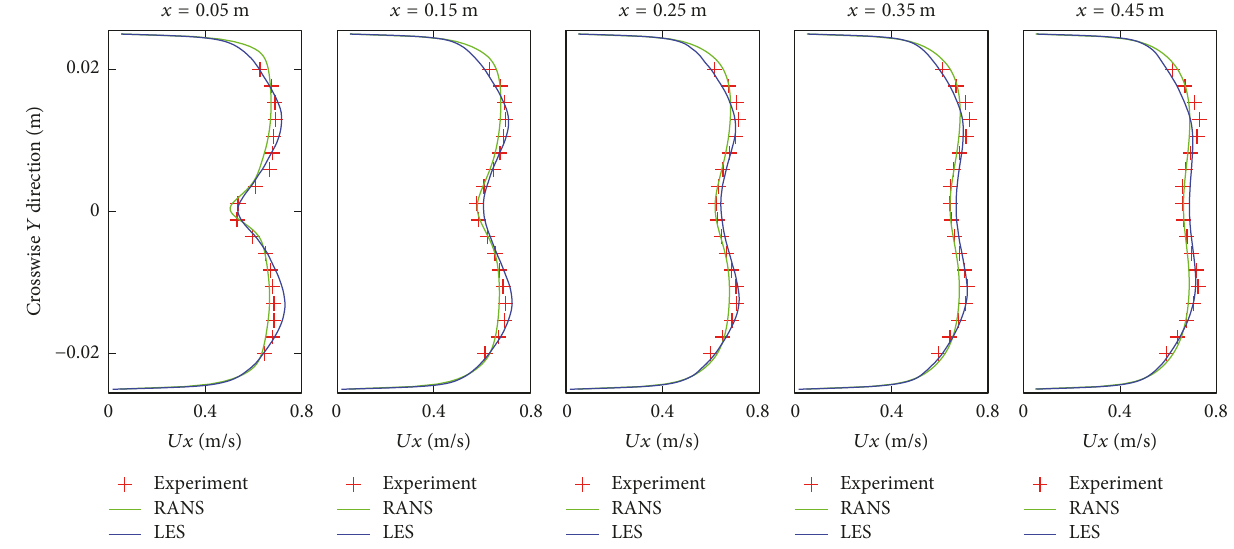
Figure 8: The streamwise velocity profiles at different locations for the single liquid case.